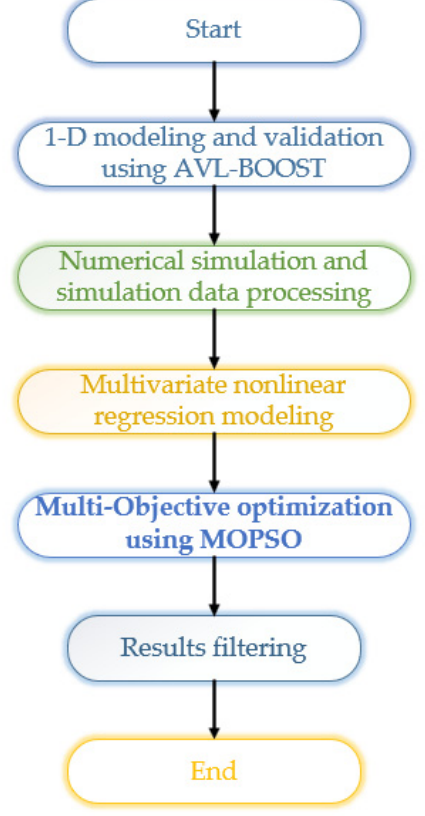
Figure 1. Summary of the working routine.